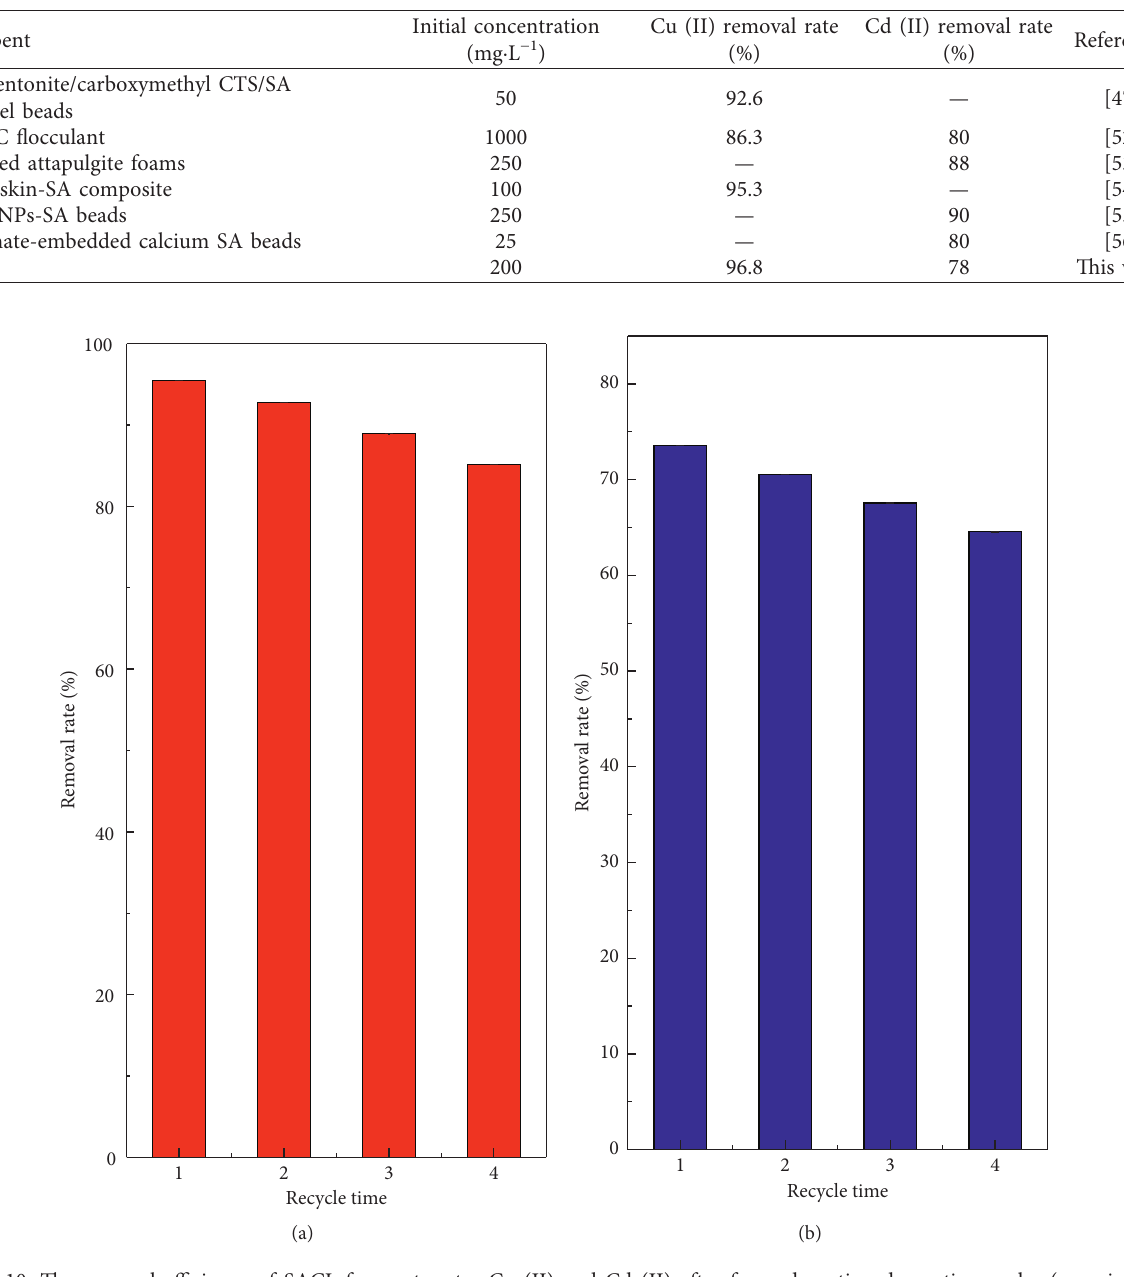
Figure 10: The removal efficiency of SACL for wastewater Cu (II) and Cd (II) after four adsorption-desorption cycles (experimental condition: Cu (II) concentration � 200mg · L − 1 ; Cd (II) concentration � 200mg · L − 1 ; contact time � 180min; amount of adsorbent � 4g; pH � 4; and agitation speed � 150 rpm) (error bars represent the standard deviation of three